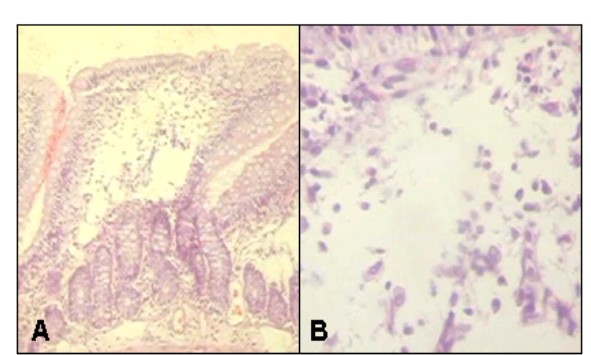
FIGURE 2 - Histological analysis comparative graph of intestinal mucosal injury of rats of the groups A, B and C according to CHIU and col. 6